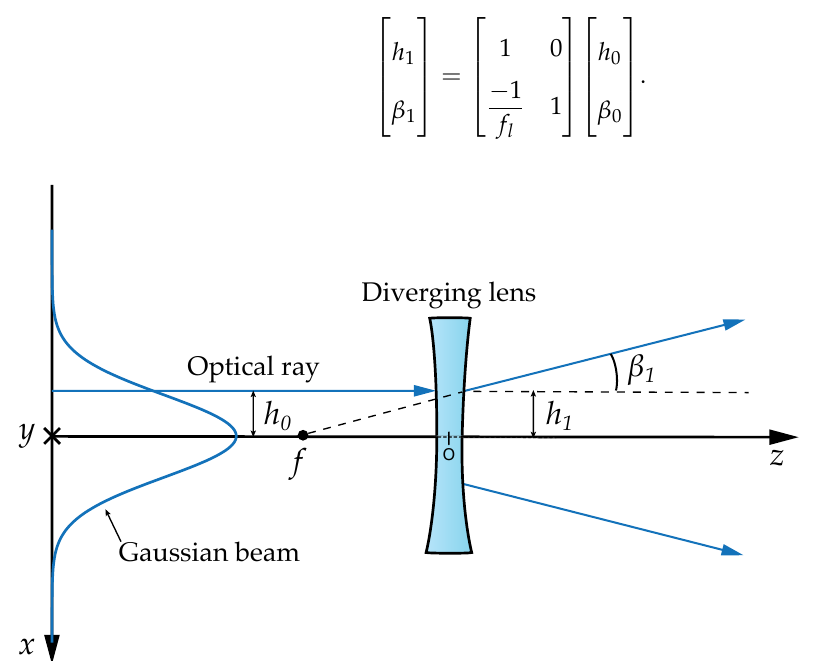
analysis using the paraxial approximation. The optical ray coordinates are defined as ( h , β ) , where h is the height and β is the slope angle relative to the optical axis. The effect of the lens on the initial ray coordinates is obtained by multiplication with the optical element matrix of the lens, given by [4]